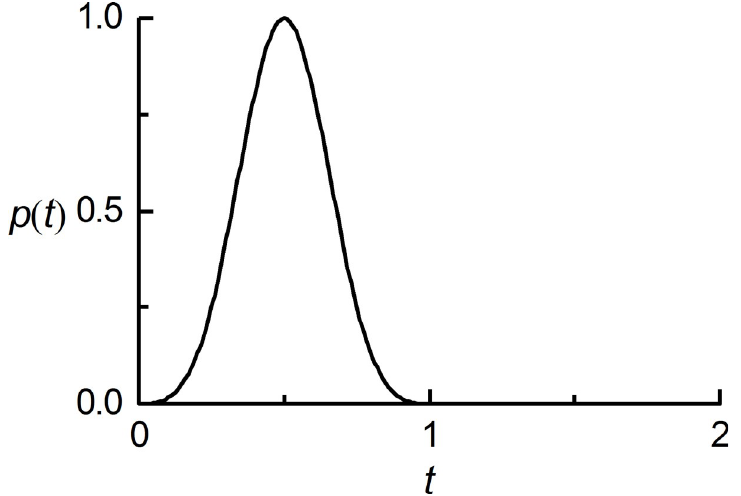
Fig 5. Time function of the concentrated